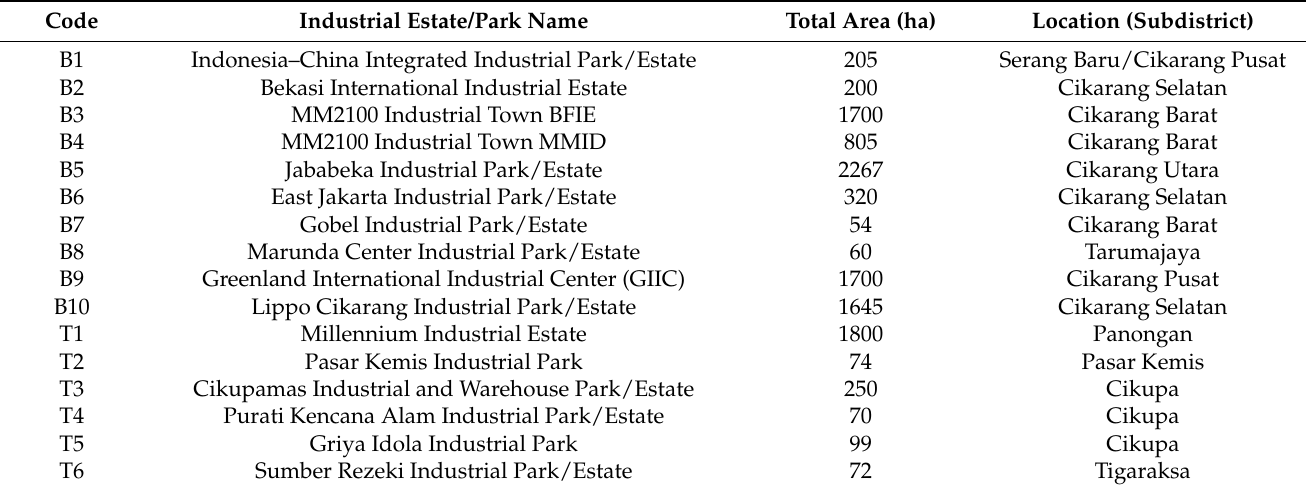
Table 2. List of LSIEP in Bekasi and Tangerang